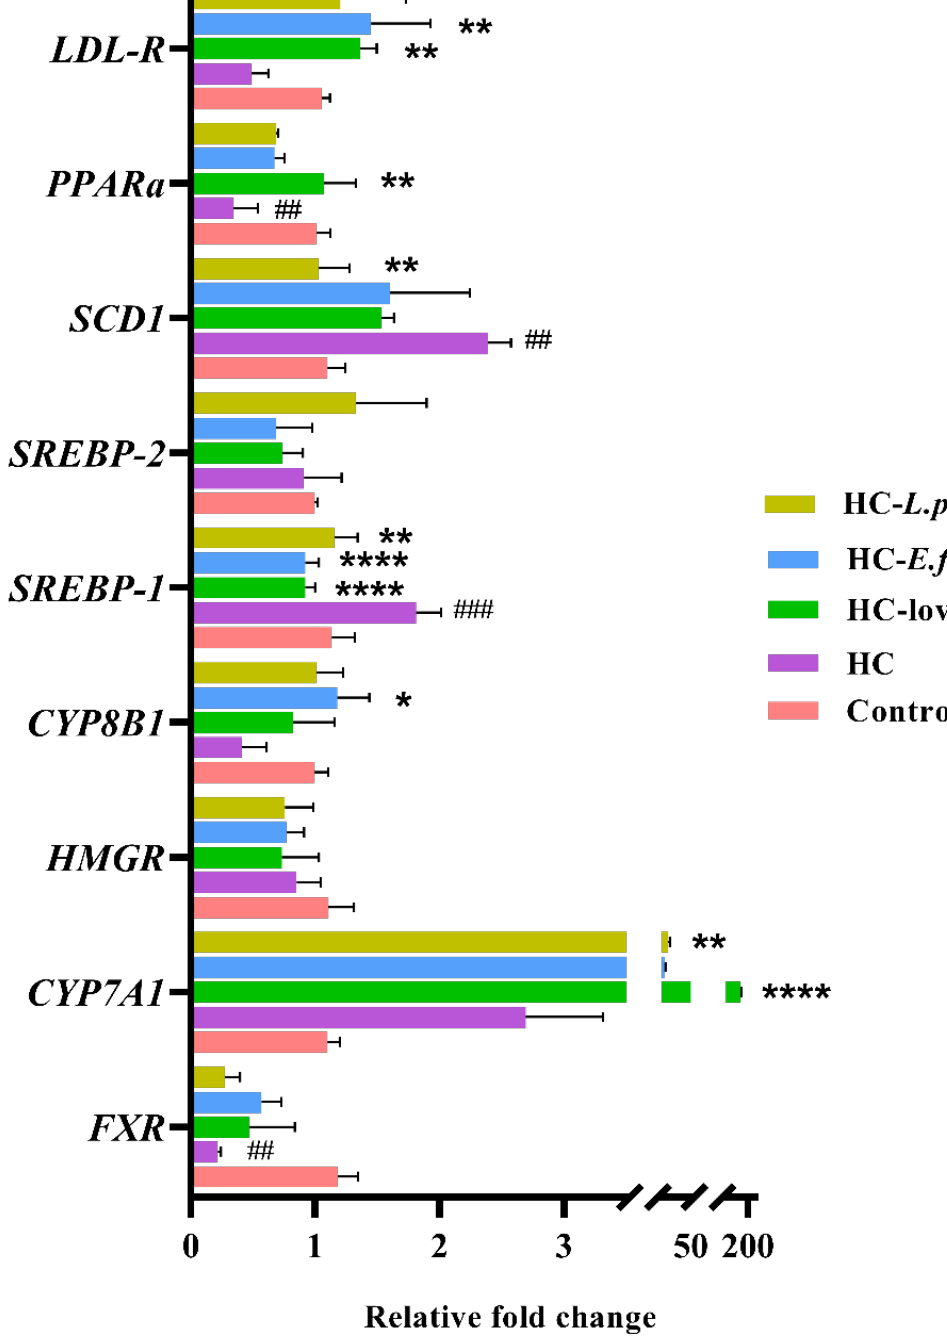
Figure 4. The mRNA expression levels of genes related to lipid metabolism in the liver. FXR stands for Farnesol X Receptor, and HMGR is named for 3-hydroxy-3-methyl glutaryl coenzyme A reductase. p -values were determined using a one-way ANOVA with Tukey’s test for post-hoc analysis, n = 6. Significant differences between the HC group versus control group are indicated as # p < 0.05, ## p < 0.01, ### p < 0.001. Significant differences in the HC-lovastatin, HC- E. faecium strain 132 or HC- L. paracasei strain 201 group versus HC group are indicated as * p < 0.05, ** p < 0.01, **** p <